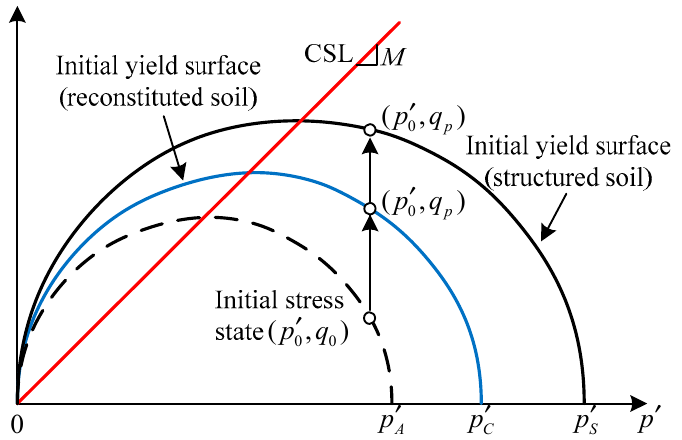
Figure 4. Elastic stress trajectory and over-consolidation ratio of structured soils.